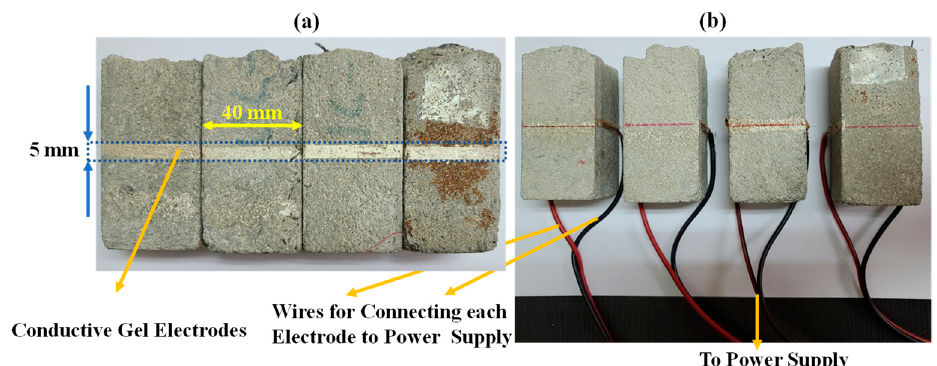
Figure 1. Conductive gel electrode and wire-connection preparation on the prisms. ( a ) Conductive gel electrode. ( b ) Wire-connection preparation on the prisms.